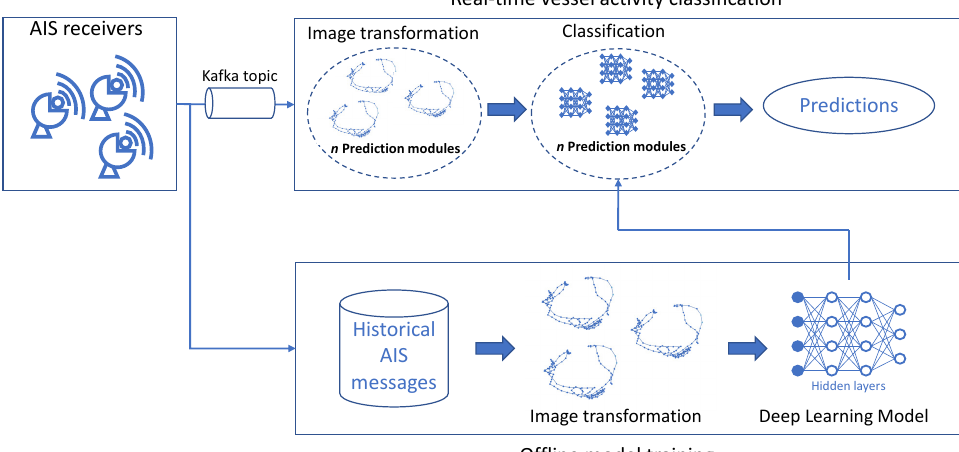
Figure 6. System